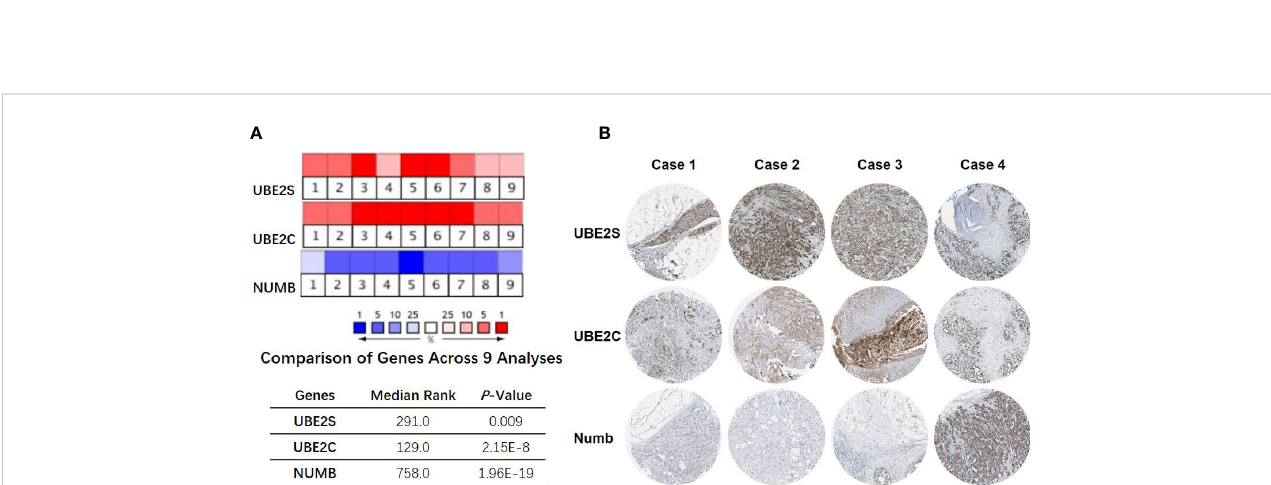
FIGURE 3 Correlation of UBE2S, UBE2C, and Numb expression. (A) The mRNA levels in breast cancer samples and corresponding normal controls across nine analyses (Oncomine database). The median rank and p-value for the genes across each of the analyses are shown in the graph. (B) Representative images of immunohistochemical staining of UBE2S, UBE2C, and Numb in four groups of breast cancer tissues, with each case from the same patients. Breast cancer tissues with medium or high protein staining of UBE2S and UBE2C have negative or weak staining of Numb protein (Cases 1 – 3) whereas tissues with lower levels of UBE2S and UBE2C protein expression display strong staining of Numb protein (Case 4). Data were obtained from the Human Protein Atlas (HPA)